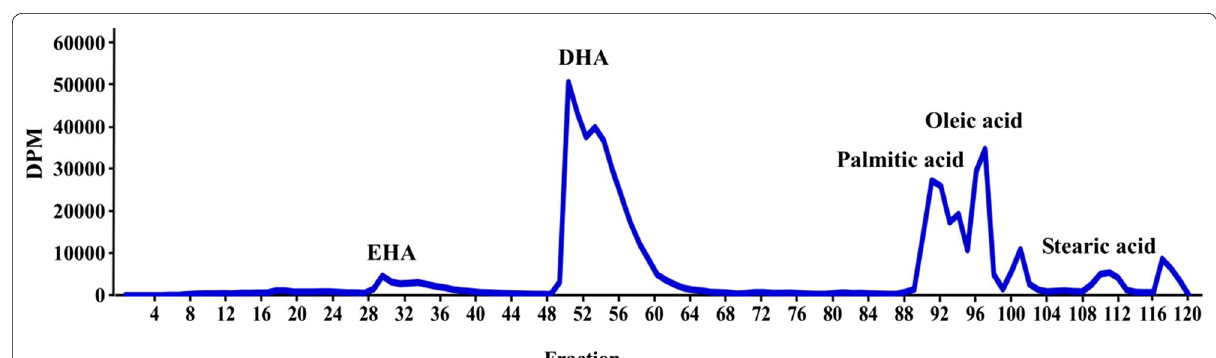
Fig. 4 The activity map for the 14 C-labeling fatty acids in C. cohnii . Five fatty acids in different elution times were marked out. Totally 120 fractions were collected, 0.5 min/per fraction. Five parallel samples were analyzed in same